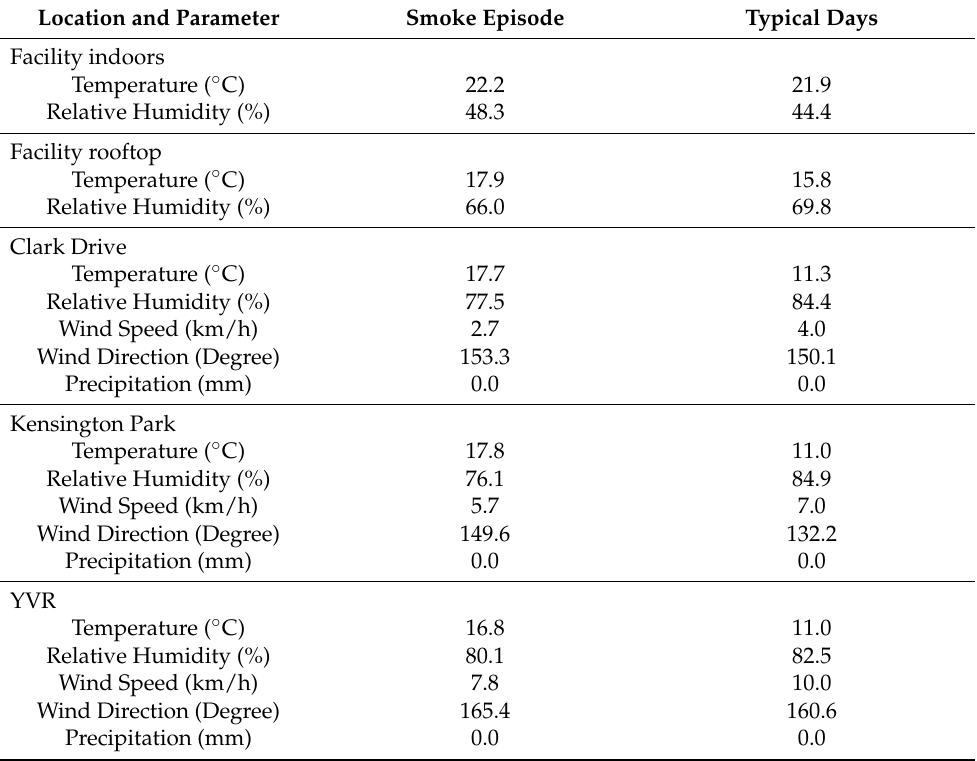
Table 4. The 24-h average of meteorological conditions during the smoke episode and typical days. All indoor sensors were aggregated in the indoor facility calculations. Outdoor sensors are the rooftop air quality egg, Clark Drive, Kensington Park, and Vancouver International Airport (YVR) which are part of the National Air Pollution Surveillance (NAPS)